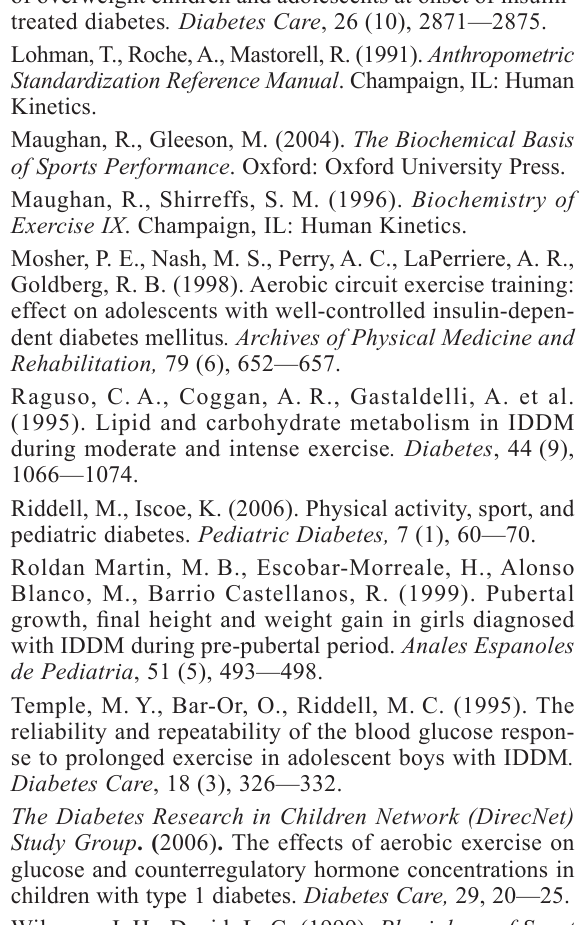
exercises — swimming and aerobics — redu- ced blood glucose concentration, but a marked change of this index was observed after the physical activity in the